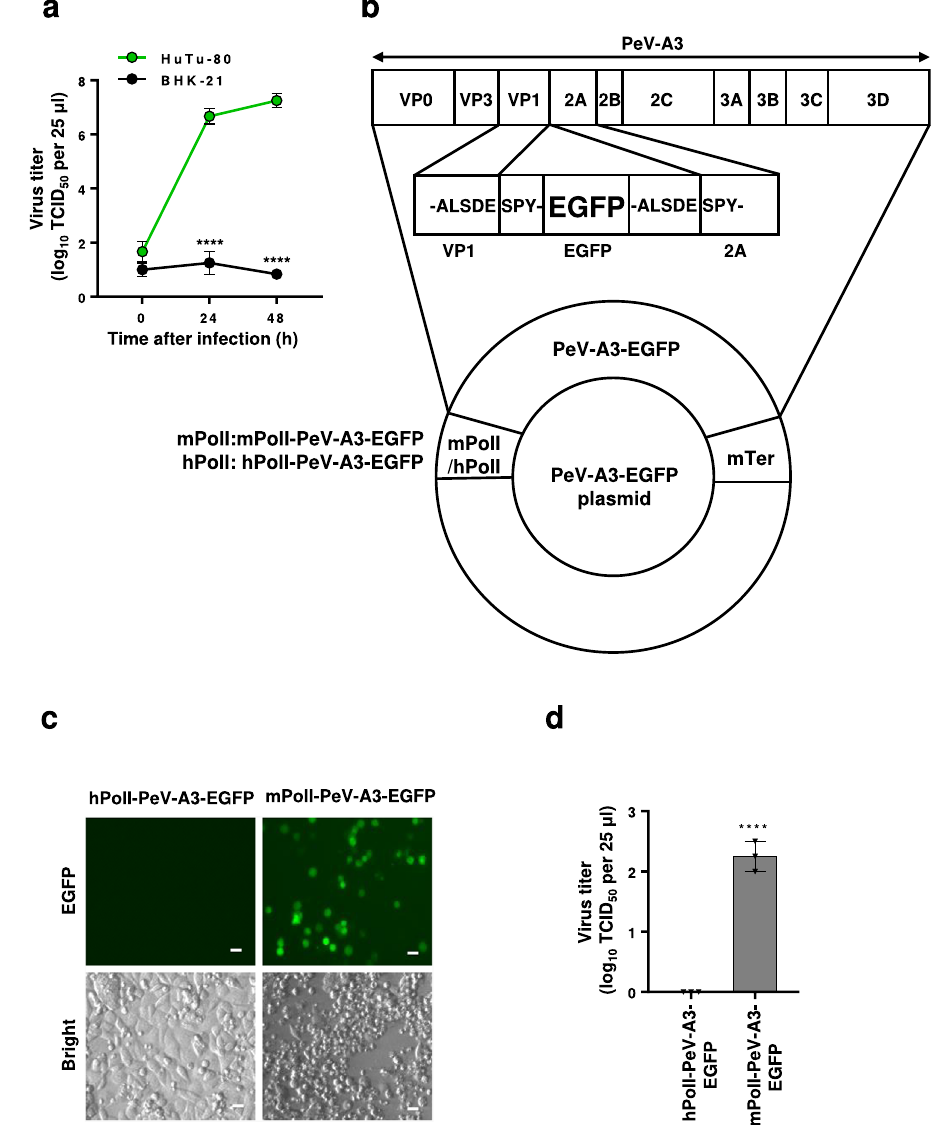
Fig. 1 | PeV-A3 does not infect hamster BHK-21 cells. a BHK-21 (black circle) and HuTu-80(greencircle)cellswereinfectedwithPeV-A3(A308/99)atanMOIof0.01, and the amount of virus (virus titer) in the culture supernatant wasmeasured at 0, 24 and 48h after infection. The virus titers in the culture supernatant of infected cells are shown as the mean and the standard deviation (s.d.) from triplicate experiments. Data from one experiment representative of two independent experiments ( N =2) are shown. P values were calculated by a two-way ANOVA with Sidak ’ s multiple comparisons test. **** P <0.0001. b The hPolI-PeV-A3-EGFP and mPolI-PeV-A3-EGFP plasmids contain human (hPolI) and mouse (mPolI) RNA polymerase I promoters in addition to PeV-A3-EGFP DNA, respectively, and also have a transcription terminator DNA (mTer) of the mouse ribosomal gene. The EGFP in PeV-A3-EGFP has a PeV-A3 3C protease recognition cleavage